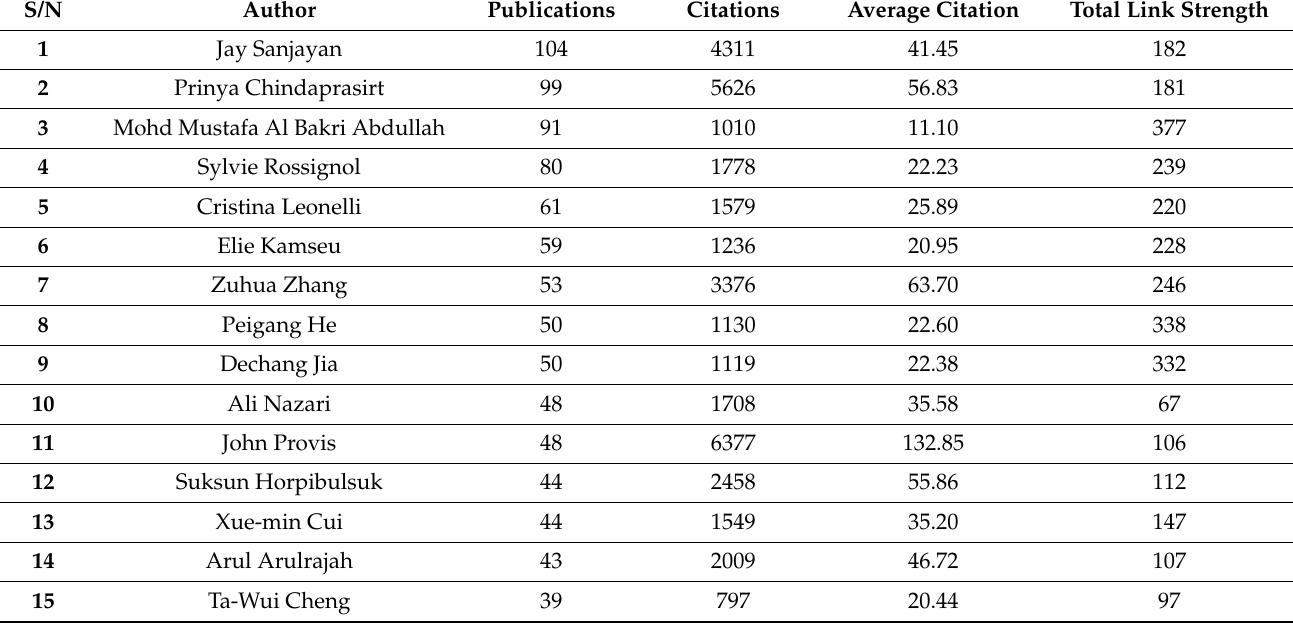
Table 5. Authors with a minimum of 30